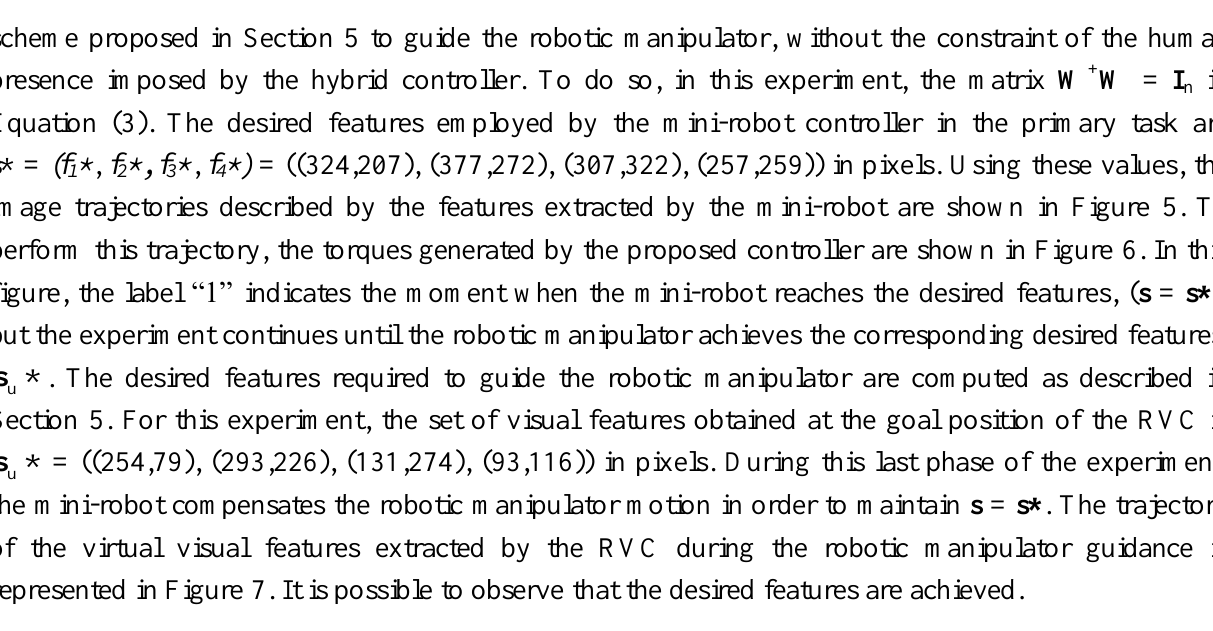
Figure 5. Trajectory of the visual features extracted by the camera at the end of the mini-robot during the first experiment.